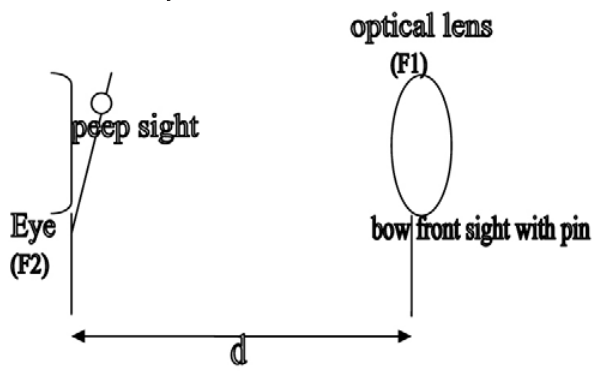
Figure 1. Illustration of the one lens system With the one lens system, the archer only uses one lens (F ), and this lens is placed in the front bow 1 sight plane. The uncompensated refractive error of